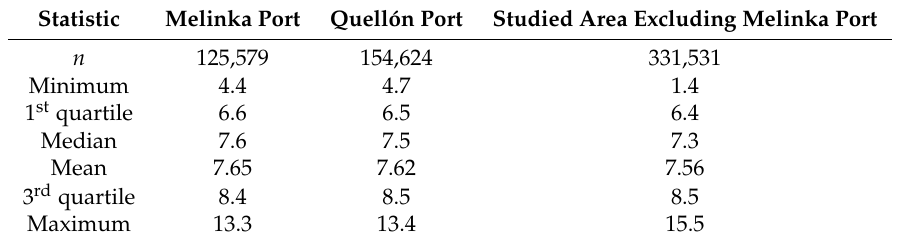
Table 2. Summary of the main statistics of sea urchin sizes (cm) in the three data subsets considered. Statistic